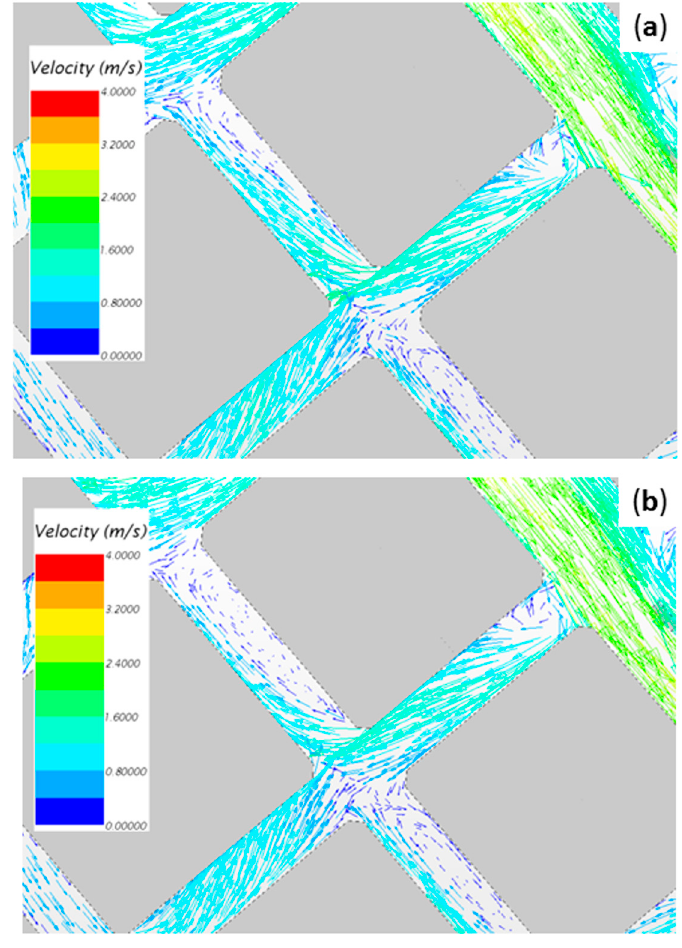
Figure 11. ( a ) Flow pattern in Current-1 case; ( b ) Flow pattern in New-1 case within the area limited by dashed line in Figure 10.